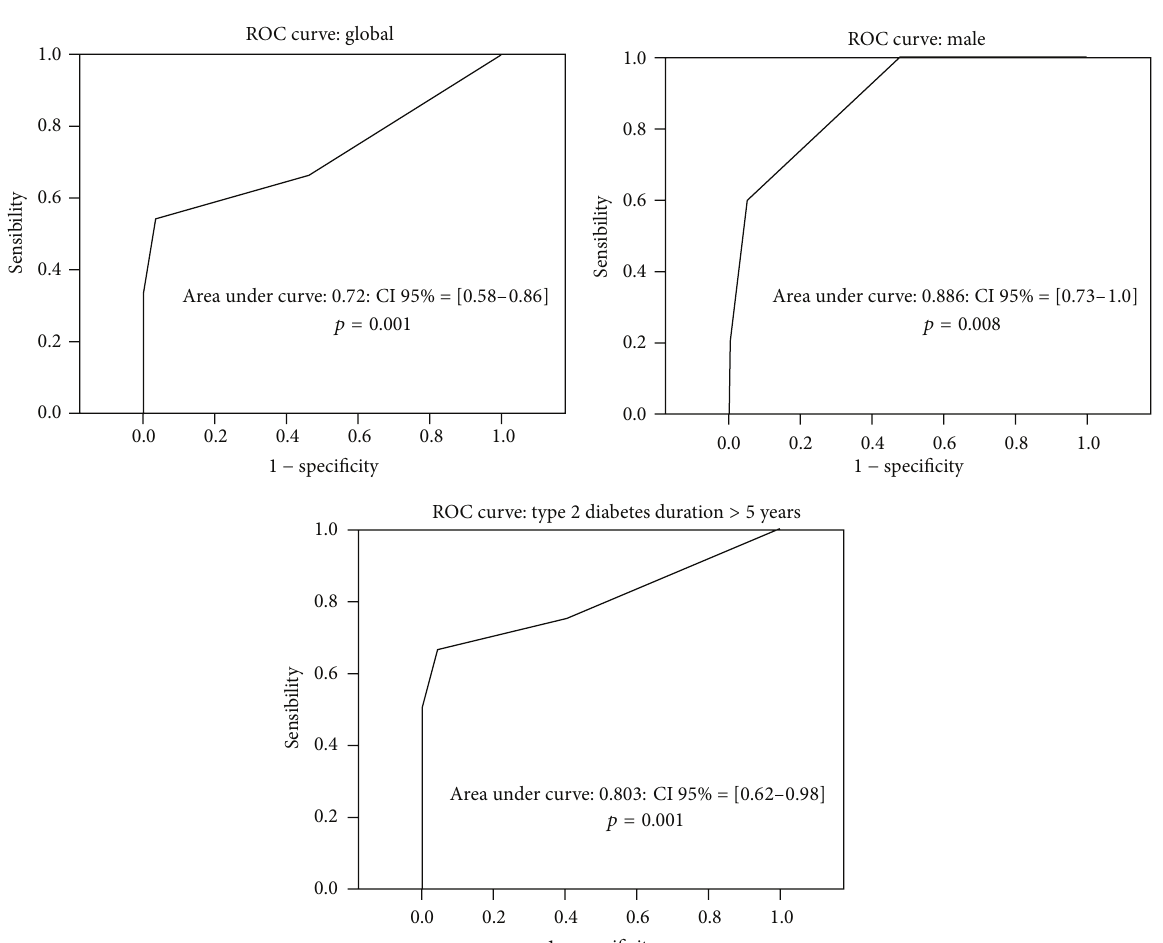
ROC curve: type 2 diabetes duration > 5 years